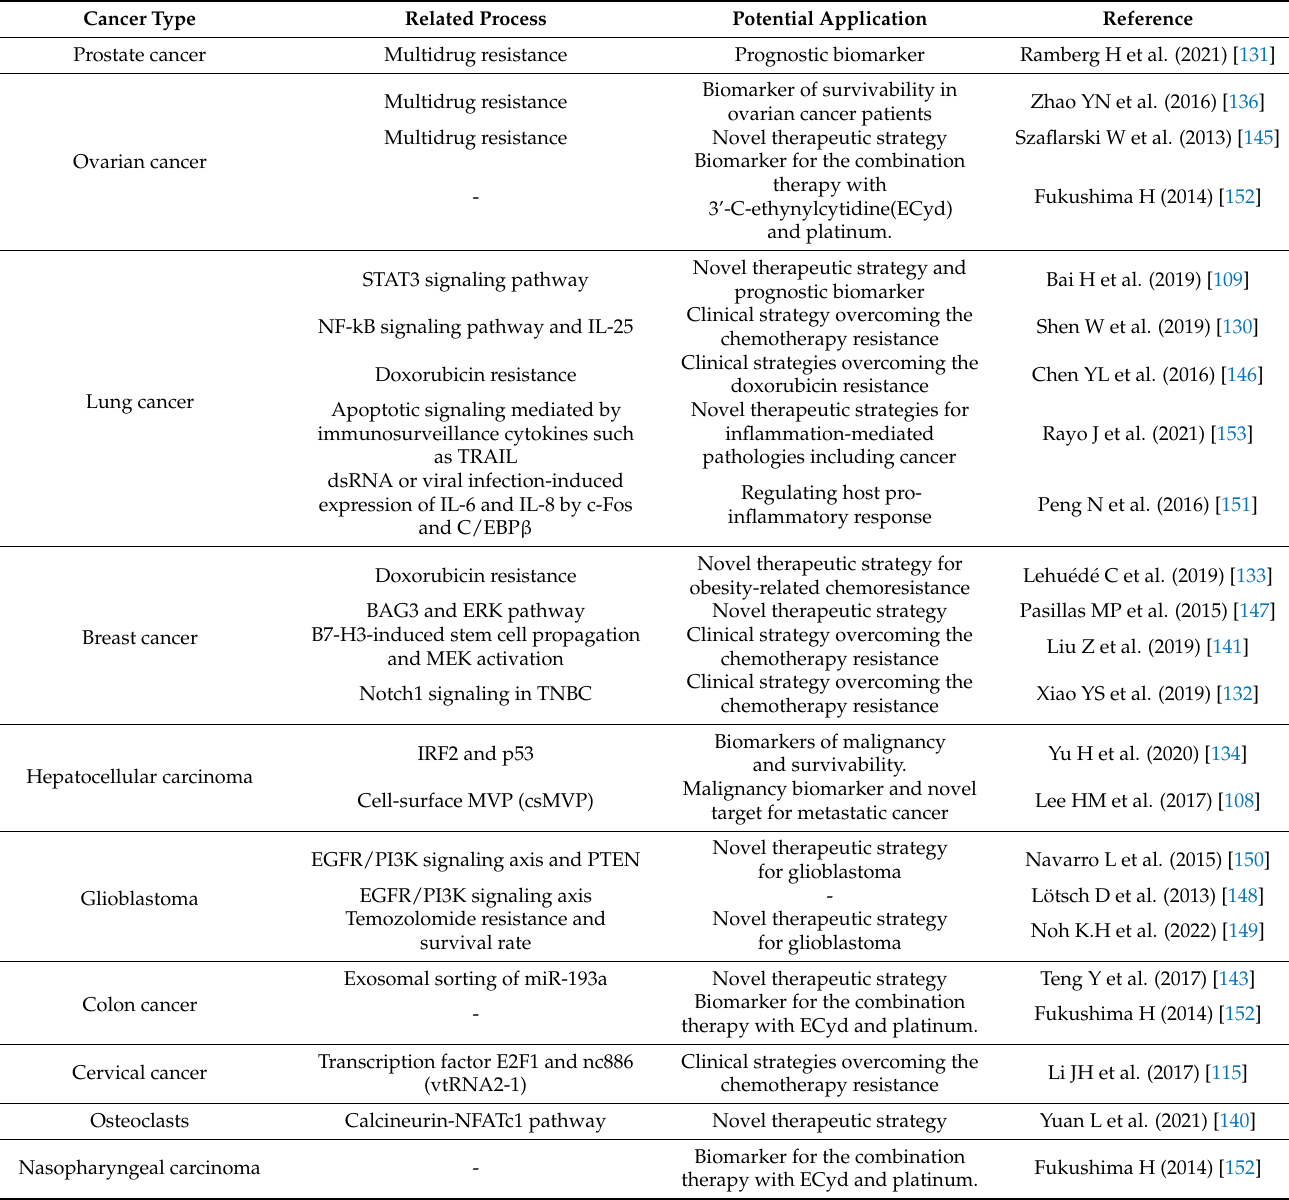
Table 1. MVP and